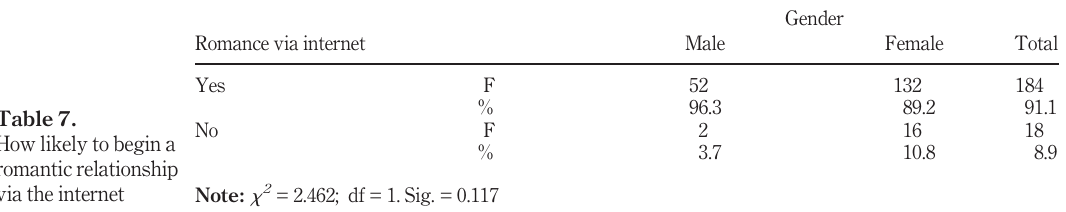
Gender TotalMale Female